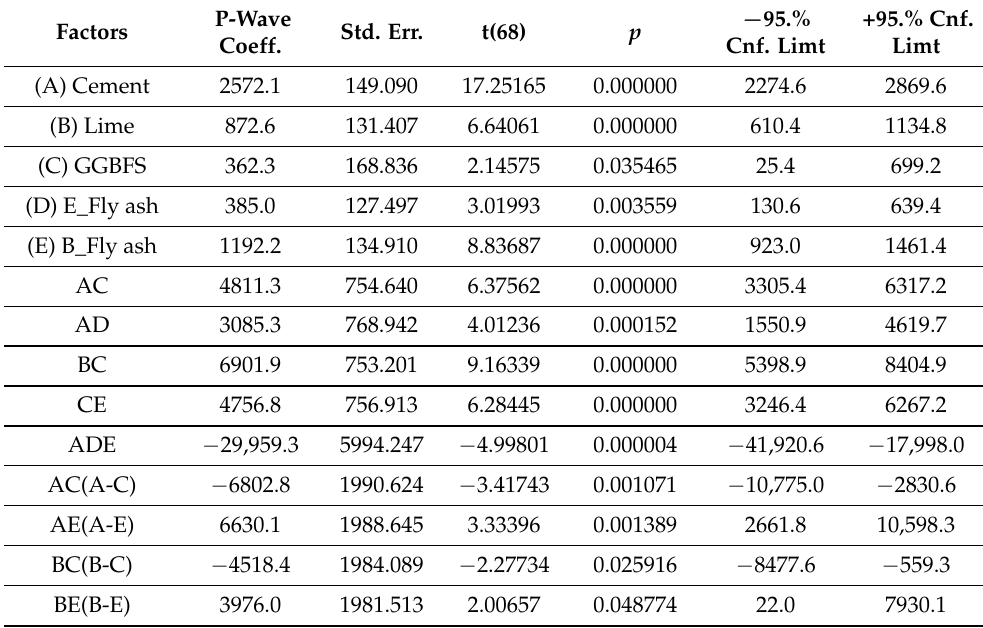
Table 4. Remaining significant effects on day 14 after the backward